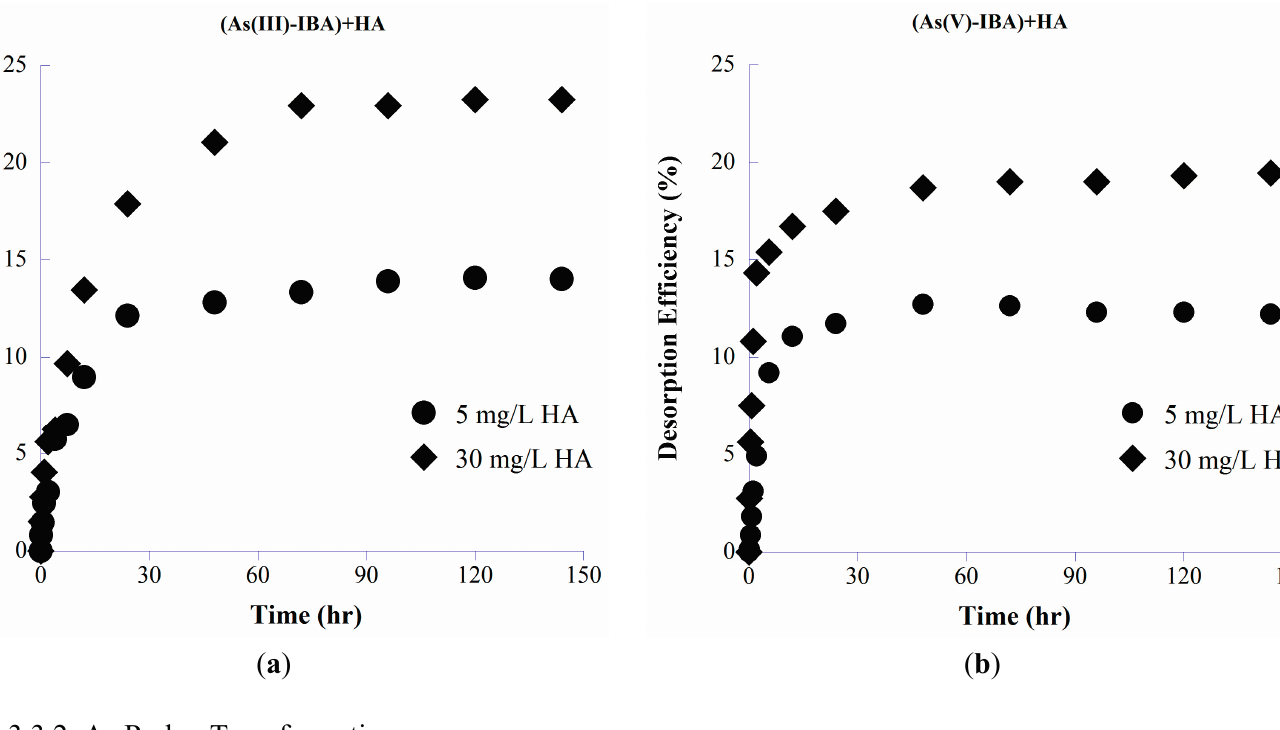
Figure 5. Desorption kinetics of (a) AsIII and (b) AsV using different concentrations of HA with initial As concentration of 5 mg/L at pH